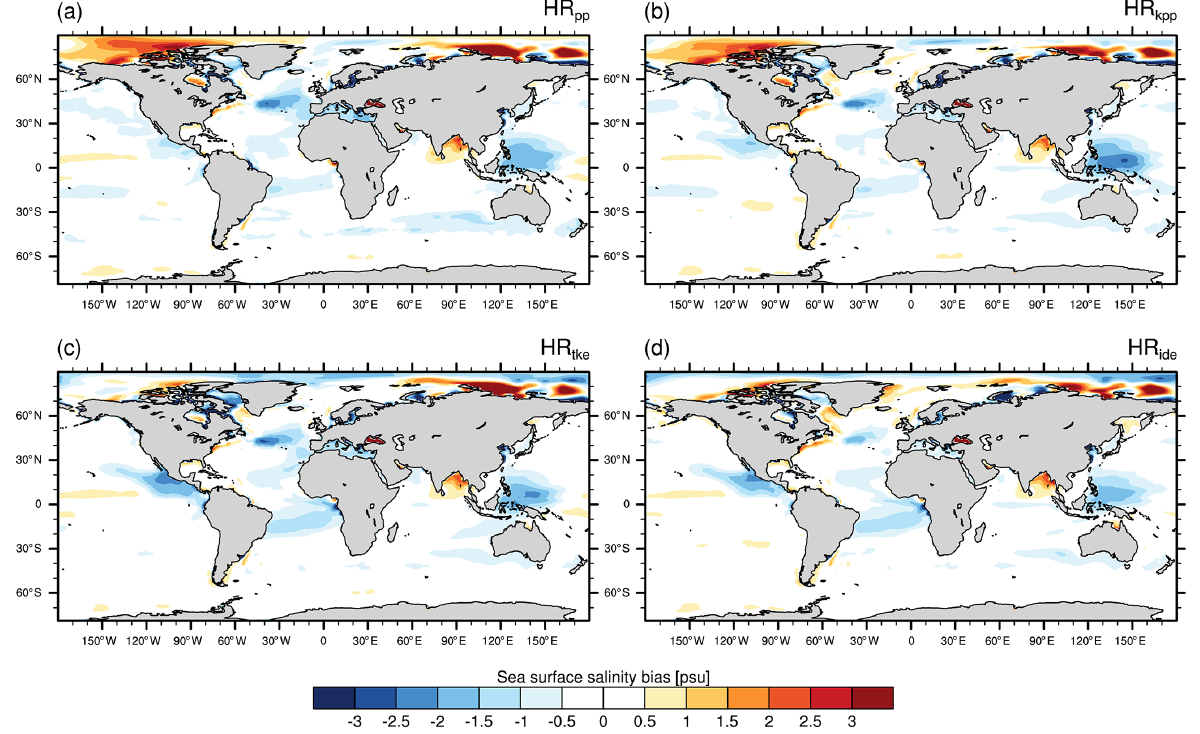
Figure 3. Time-averaged sea surface salinity bias of MPI-ESM1.2-HR minus EN4 (1945–1955) for (a) HR pp , (b) HR kpp , (c) HR tke , and (d) HR ide